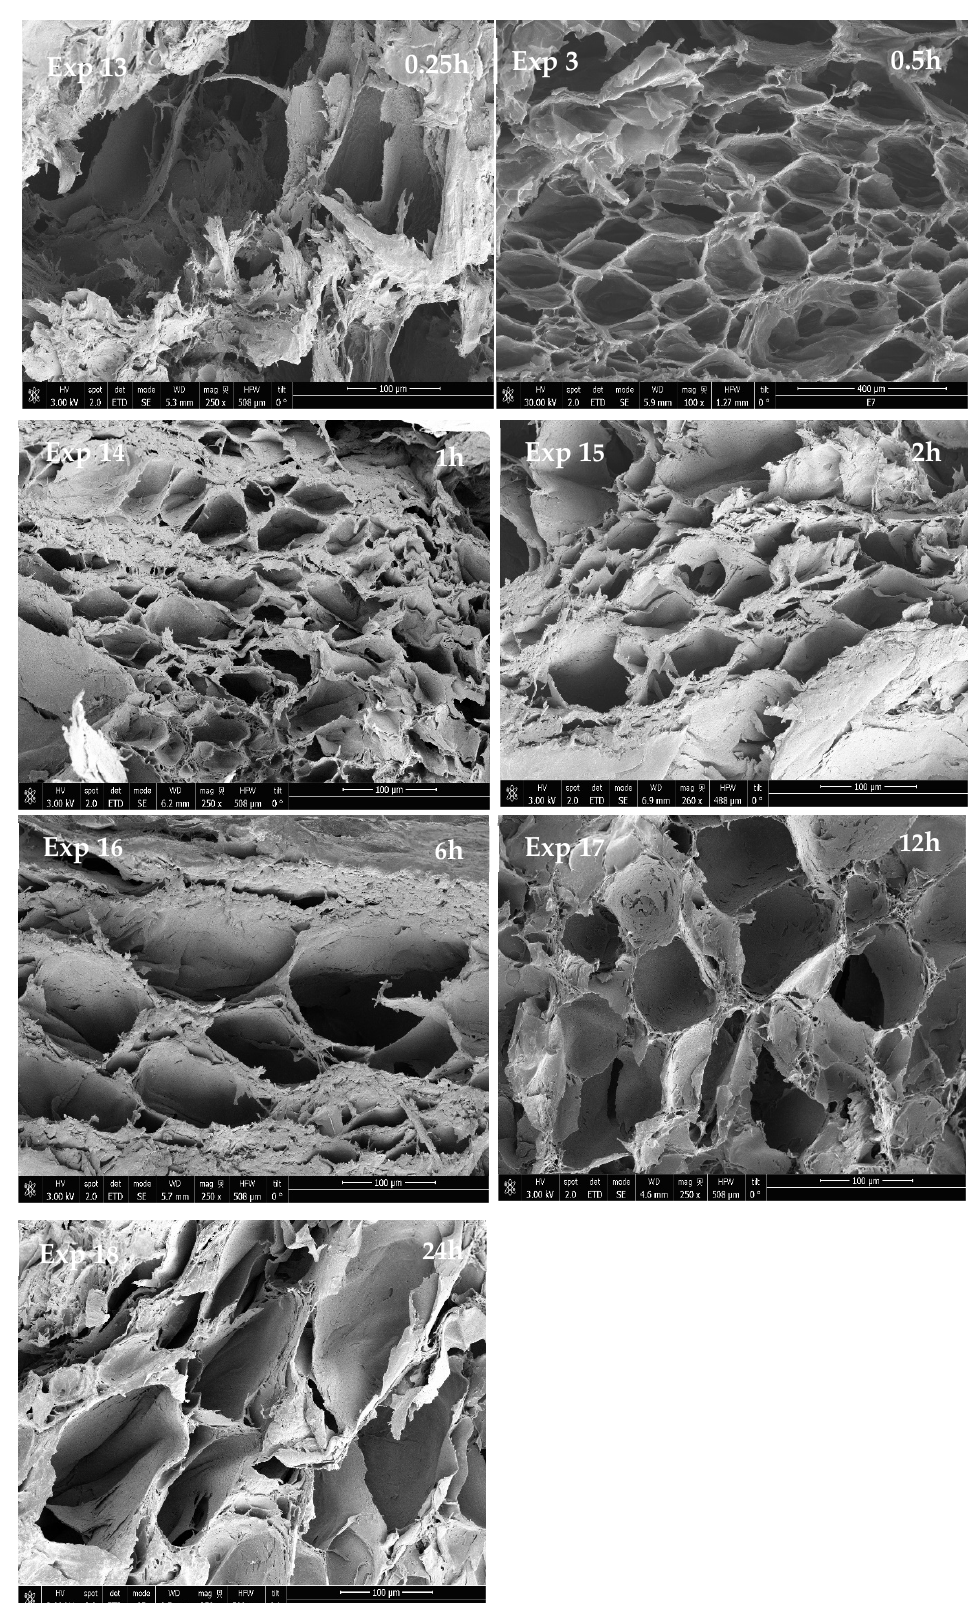
Figure 10. SEM images of formed scaffolds at 120 bar of pressure and 45 °C of temperature at different contact times.